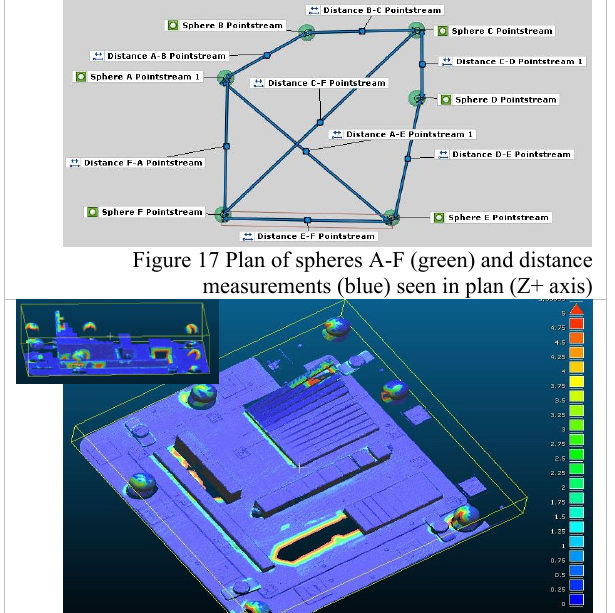
Figure 16 Sphere spacing error, Arius3D vs Nik.MMD in [mm]